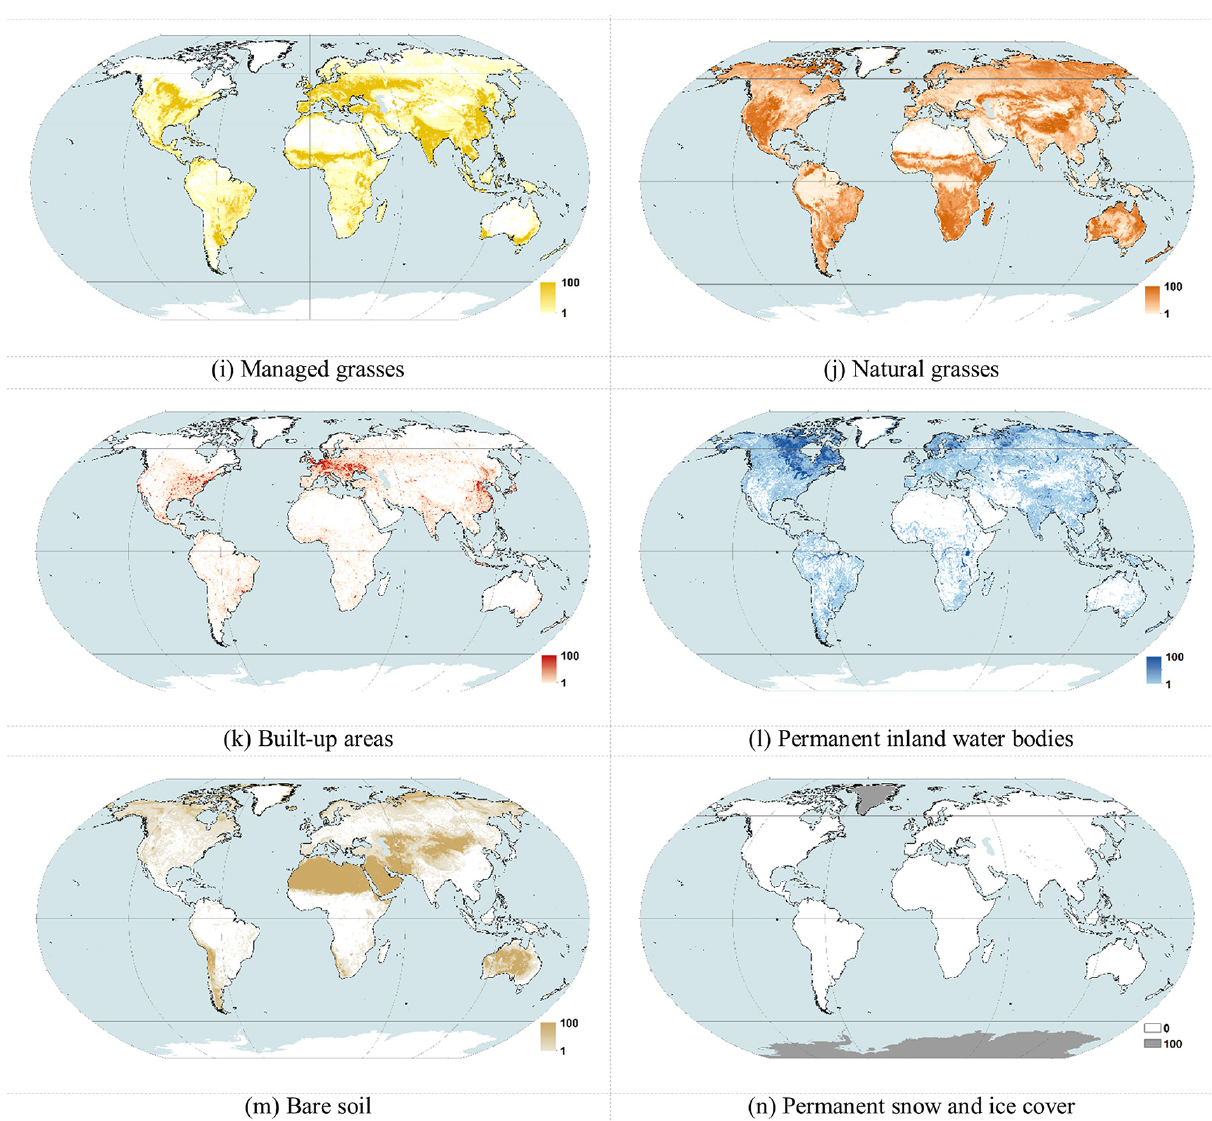
Figure 1. Percentage cover in 2010 for the 14 PFTs included in the PFT local data product at a spatial resolution of 0 . 25 ◦ × 0 . 25 ◦ . (a) Broad- leaved evergreen trees, (b) broad-leaved deciduous trees, (c) needle-leaved evergreen trees, (d) needle-leaved deciduous trees, (e) broad- leaved evergreen shrubs, (f) broad-leaved deciduous shrubs, (g) needle-leaved evergreen shrubs, (h) needle-leaved deciduous shrubs, (i) man- aged grasses, (j) natural grasses, (k) built-up areas, (l) permanent inland-water bodies, (m) bare soil, and (n) permanent snow-and-ice